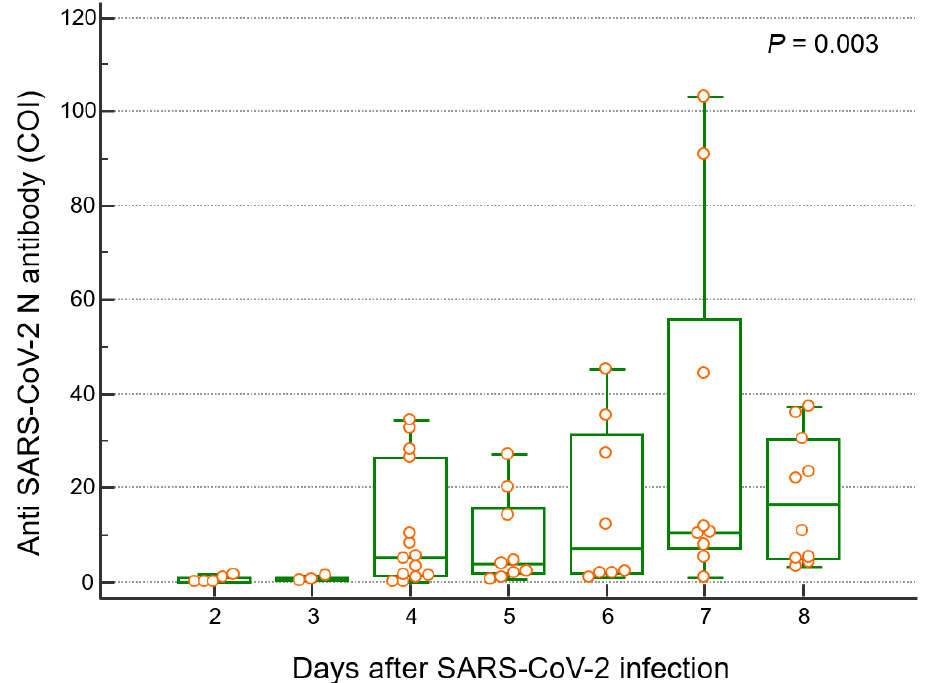
Figure 3. Distribution of anti-SARS-CoV-2 N antibody levels according to the number of days after SARS-CoV-2 infection. Anti-N antibody at different time points classified by five days is described.